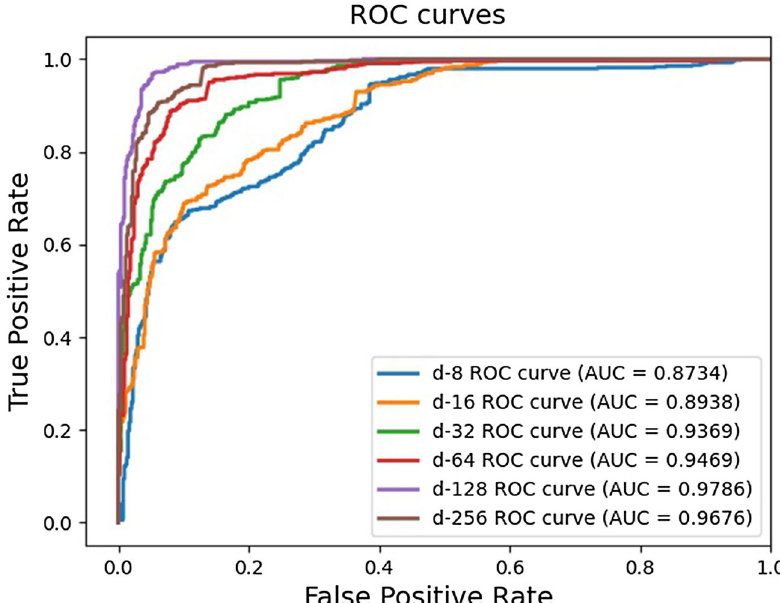
Figure 3. Impact of embedding size.